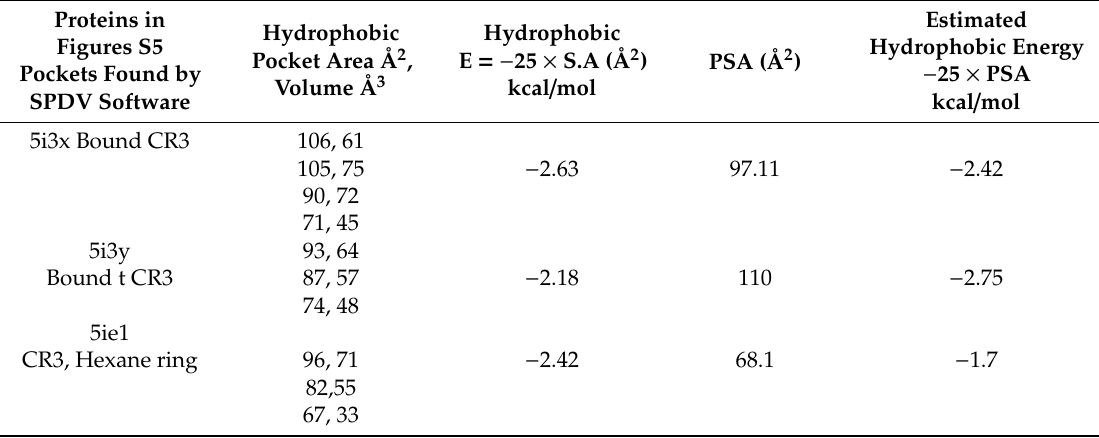
Table 8. The areas of hydrophobic pockets in BACE1 for each inhibitor binding (Figure S5). The calculated energies resulting from hydrophobicity using the formula − 25 cal / Å 2 of surface area and comparing the estimated hydrophobic energy with that resulting from reported polar surface area (PSA)